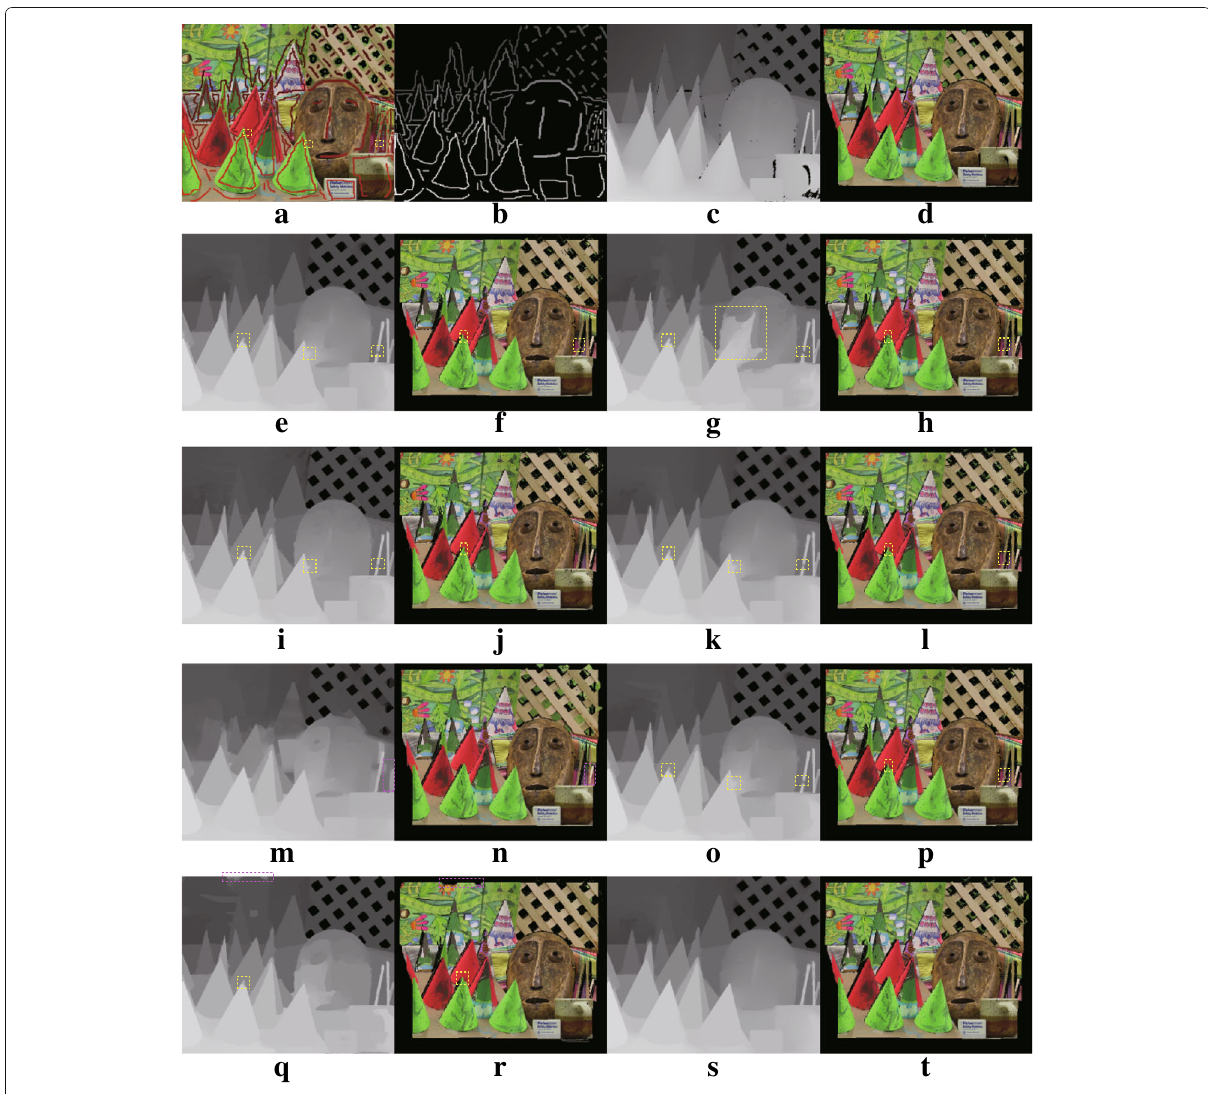
Fig. 16 Results of Cones with cross-boundary input. a User-labeled image. b Sparse depth. c Groundtruth depth. d synthesized view using c . e Depth of RW. f Synthesized view using e . g Depth of HGR. h Synthesized view using g . i Depth of NRW. j Synthesized view using i . k Depth of OPT. l Synthesized view using k . m Depth of OCP. n Synthesized view using m . o Depth of SDF. p Synthesized view using o . q Depth of (cid:2) 1 . r Synthesized view using q . s Depth of the proposed method. t Synthesized view using s . Please zoom in to see